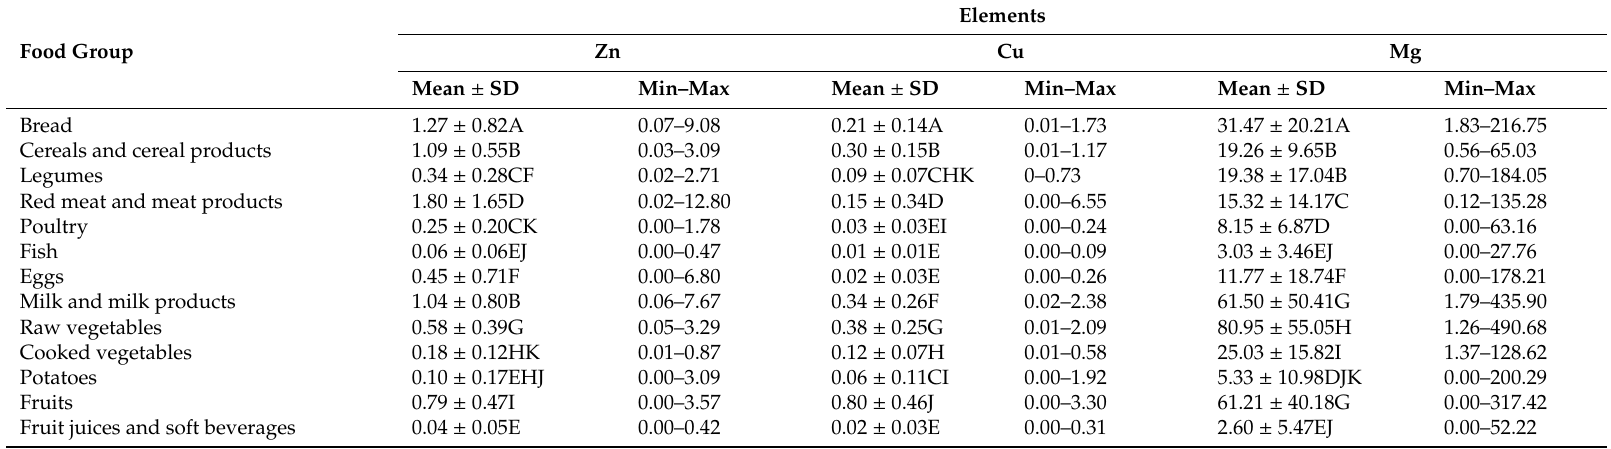
Table 4. The mean, minimum, and maximum daily intakes (mg / d) of zinc (Zn), copper (Cu), magnesium (Mg), calcium (Ca), phosphorus (P), and sodium (Na) from di ff erent food groups in adult population in Shiraz,